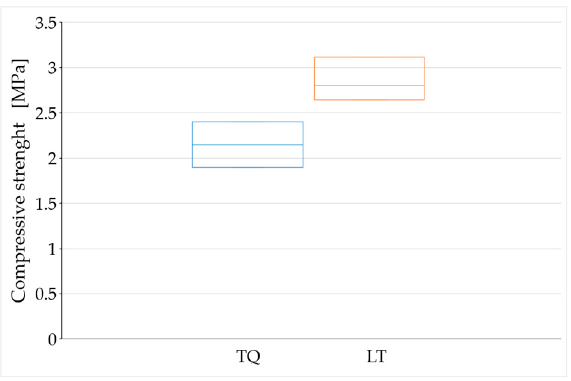
Figure 13. Minimum, average, and maximum values of compressive strength after 180 days of curing.